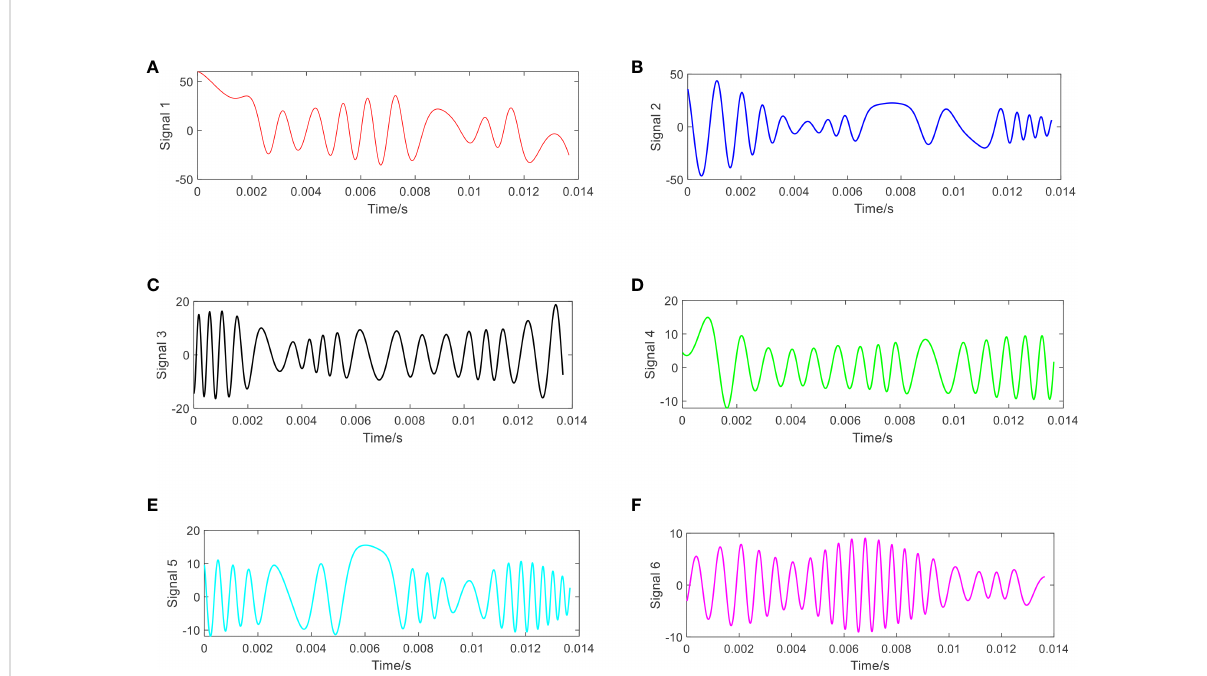
FIGURE 12 The estimated components using the ACMD method. (A) Component 1; (B) component 2; (C) component 3; (D) component 4; (E) component 5; and (F) component